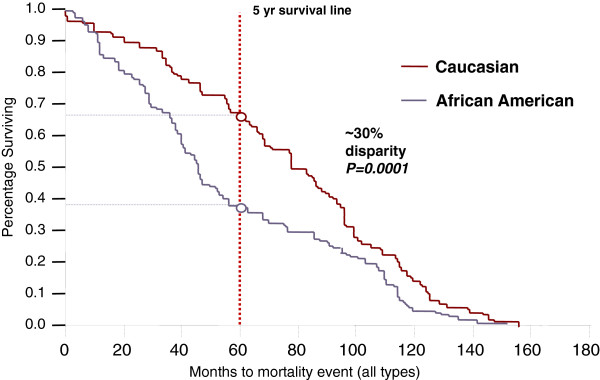
Ethnic disparities in survival rates. A Kaplan-Meir Analysis indicates our cohort suffers from the typical disparities in ethnic survival trends between Caucasian and African American (Afr. Am.) patients. Specifically at the 5-year survival mark, there is a 30% gap between the two groups.